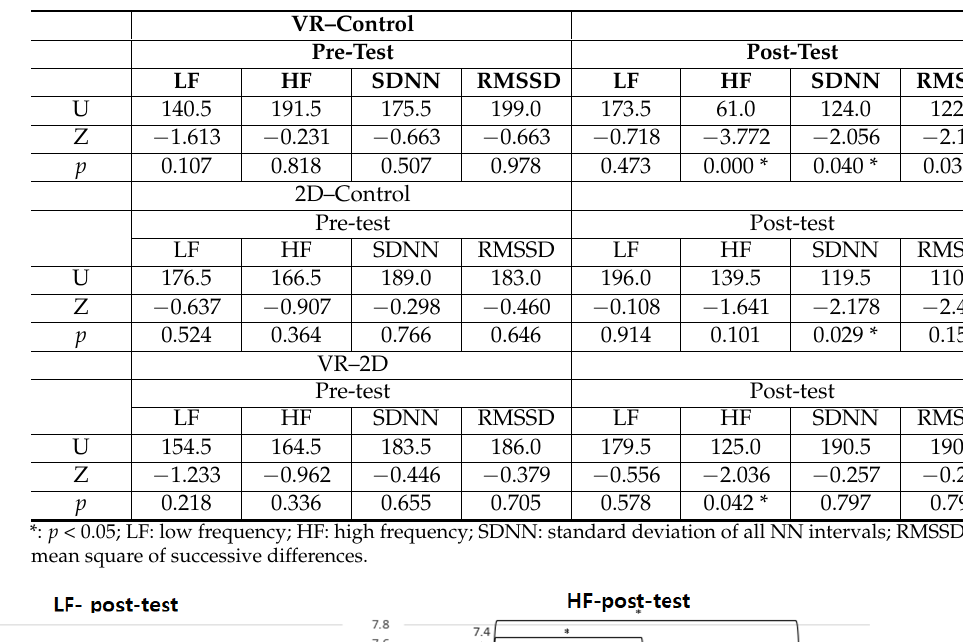
Table 3. HRV pre–post result.